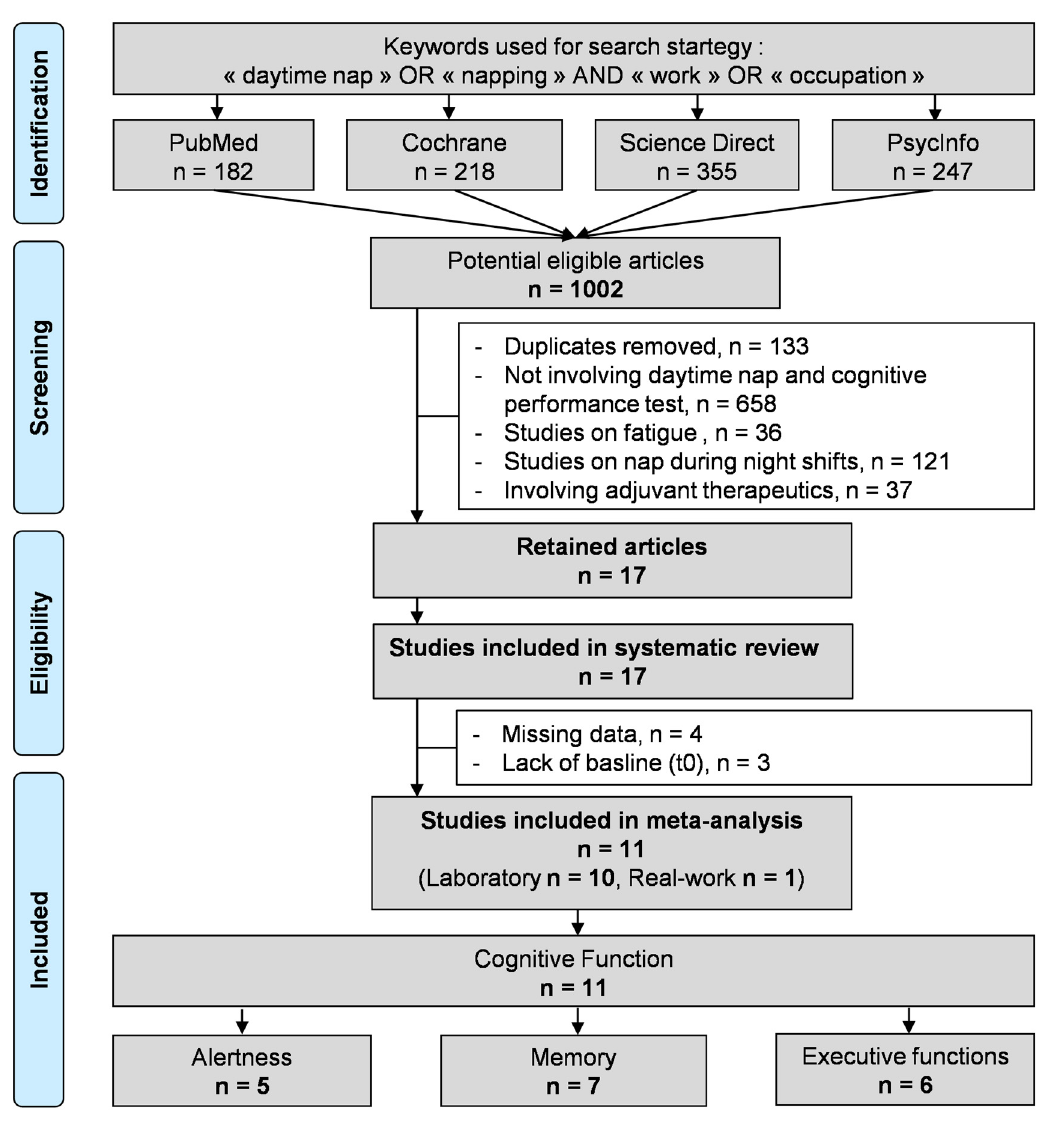
Figure 1. Search Figure 1. Search strategy.